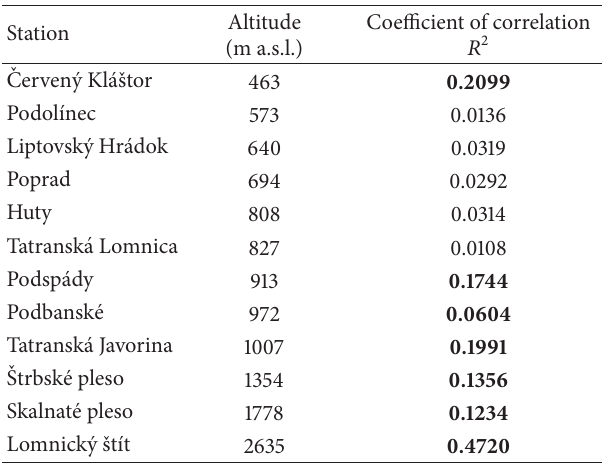
Table 2: Correlation coefficients of the SPI trends at the